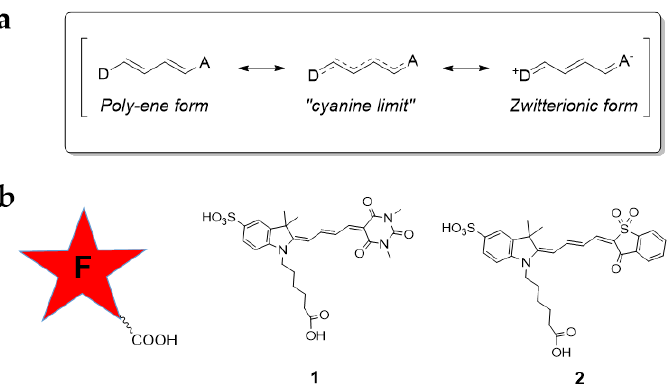
Figure 1. ( a ) General structure of meroCyanine dyes showing their resonance forms. ( b ) Structures of the meroCyanine dyes meroBA-COOH ( 1 ) and meroSO-COOH ( 2 ). Recently, we have reported aldehyde containing meroCyanine dyes and its derivati- zation of Vancomycin generating a Gram-positive bacterial fluorescent probe [20]. In the tive specific imaging agent based on the same class of meroCyanine fluorophores. We thus report here the preparation of two novel environmentally sensitive meroCyanine dyes containing a carboxylic acid group as a key anchoring point, to allow the attachment of specific bacterial-targeting ligands. After extensive characterization of their photophysical behavior (absorption, emission, extinction coefficient, quantum yield, brightness and flu- orescence lifetime) in a variety of solvents, they were used to prepare red-shifted poly- myxin-based imaging probes and evaluated for their ability to fluorescently, and selec- tively, label Gram-negative bacteria. 2. Materials and Methods 2.1. General Methods Commercially available reagents were used as received. Thin-layer chromatography was performed on aluminum sheets coated with silica gel containing the phosphor F254 and were visualized by UV- illumination (λ = 254 nm and 365 nm). Flash column chroma- tography was performed using an appropriately sized glass column filled with silica gel 60 (mesh 0.040–0.063). NMR spectra were recorded on an automated Bruker AV500 in the indicated deuterate d solvents at 298 K. Chemical shifts are reported on the δ scale in parts per million (ppm) and are referenced to the residual non-deuterated solvent peak for 1 H NMR, and to the deuterated carbon of the solvent for 13 C NMR. Coupling constants ( J ) are given in Hertz. Analytical reverse-phase high-performance liquid chromatography (RP– HPLC) was performed on an Agilent 1100 system equipped with a Kinetex XB-C18 col- umn (50 × 4.6 mm, 5 μm) with a flow rate of 1 mL/min and eluting with H 2 O/Acetonitrile (95/5) to H 2 O/Acetonitrile (5/95) all containing 0.1% formic acid, over 6 min, holding at 95% for 3 min, with detection at 254, 550, 600, or 650 nm and by an evaporative light scat- tering detector. Preparative HPLC was performed on an Agilent 1100 system equipped with a Kinetex XB-C18 column (150 × 21.2 mm, 5 μm) with a flow rate of 10 mL/min and eluting with H 2 O/Acetonitrile (95/5) to H 2 O/Acetonitrile (5/95) all containing 0.1% formic acid, over 15 min, holding at 95% for 3 min, with detection at 550, 600, and 650 nm. Elec- trospray ionization mass spectrometry (ESI–MS) analyses were carried out on an Agilent Technologies LC/MSD Series 1100 quadrupole mass spectrometer (QMS) in ESI mode. HR-MS were obtained by the Mass Spectrometry department of the University of Edin- burgh and were performed on a Finnigan MAT 900 XLP high resolution double-focusing mass spectrometer. MALDI spectra were acquired on a Bruker Ultraflextreme MALDI TOF/TOF with a matrix solution of sinapic acid (10 mg/mL) in H 2 O/CH 3 CN/TFA